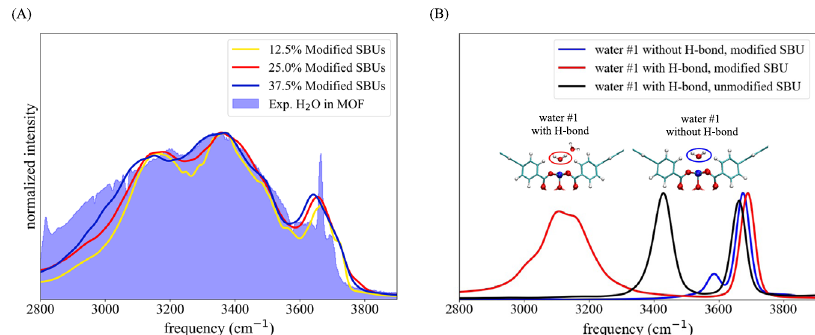
Fig. 6 Simulated water spectra in NU-1500-Cr with modi fi ed SBUs. A Simulated water spectra with 12.5% (yellow), 25.0% (red), and 37.5% modi fi ed SBUs in the framework and experimental water spectrum (shaded purple) at 25% RH. B Spectra of water #1 binding to a modi fi ed SBU without (blue) and with (red) forming a hydrogen-bond with a neighboring water molecule, and binding to a unmodi fi ed SBU with forming a hydrogen-bond with a neighboring water molecule